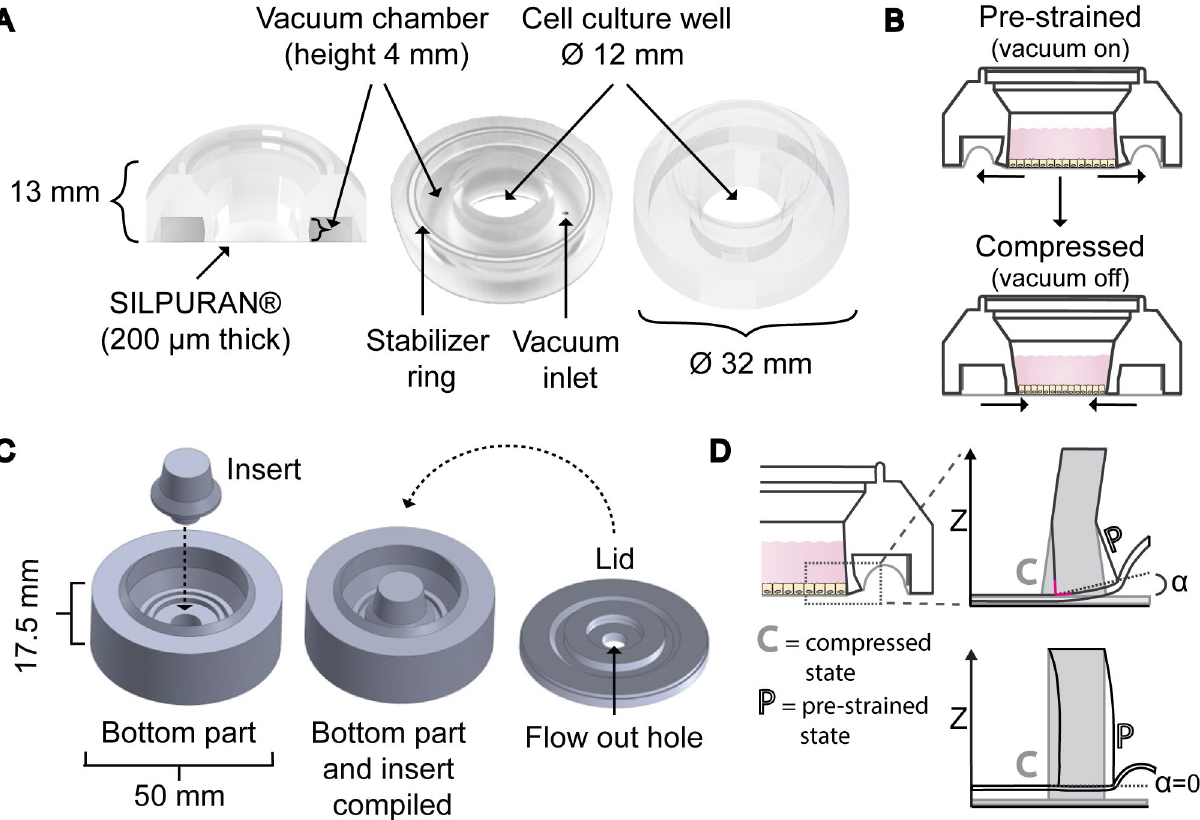
Fig 1. Structure and function of the device and the mold. (A) Structure and dimensions of the device illustrated as a cross section of the device (left), from below (center) and from above (right). (B) Diagram of the mode of action of the device. In the pre-strained state partial vacuum pressure in the vacuum chamber deforms the silicone membrane and pulls the inner walls of the cell culture well thus leading to equiaxial strain in the cell culture well. Once the pre-strain is released, the cell culture well is compressed. (C) The mold for the device consists of a bottom part, an insert, and a lid. The insert is detachable to allow an easy removal of the cured device. The hole in the lid allows excess PDMS to flow out. A weight was placed on top of the compiled mold during curing. (D) Schematic view of the inner wall of the vacuum chamber demonstrating how the hinge structure decreases z-directional movement of the silicone membrane. The hinge structure produces an angle α between the base of the inner wall and the horizontal plane. As the angle grows, the inner corner (marked in magenta) of the wall pushes the silicone membrane downwards thus compensating for the z-directional rising. Without the hinge structure (below), no angle is formed and therefore, the deformation of the wall causes the silicone membrane to rise. C refers to the compressed state of the wall, shown in grey, and P refers to the pre-strained state, shown with black